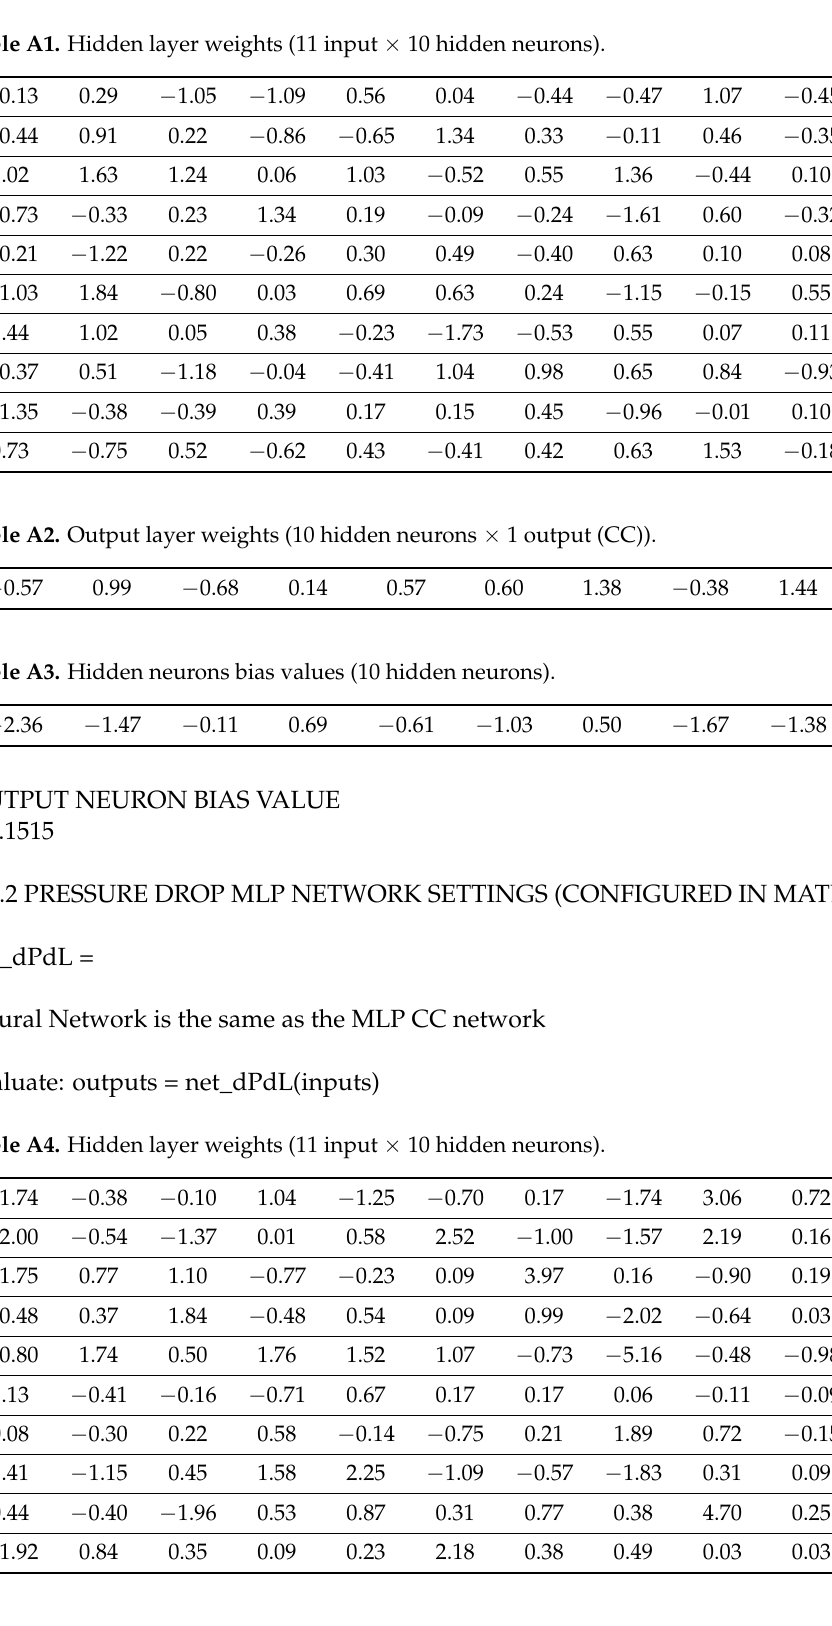
Table A5. Output layer weights (10 hidden neurons × 1 output